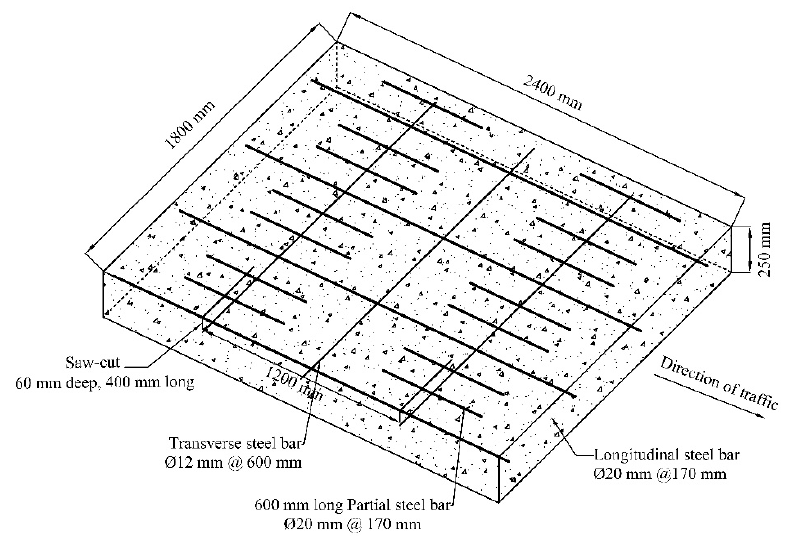
Figure 17. Reinforcement layout of ARCP-2. Table 5. Comparison of reinforcement layout of CRCP and advanced reinforced concrete pave- ment (ARCP).